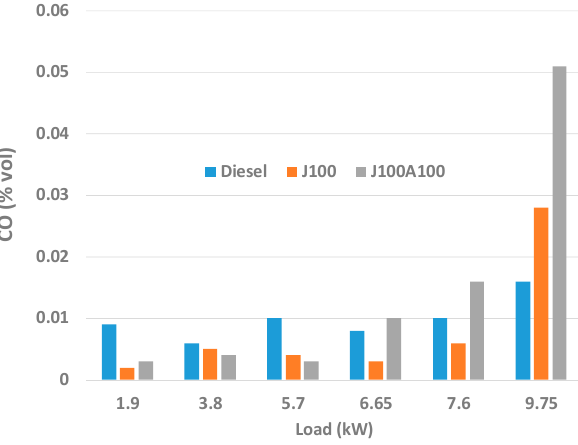
Figure 6. CO emission vs. engine load.